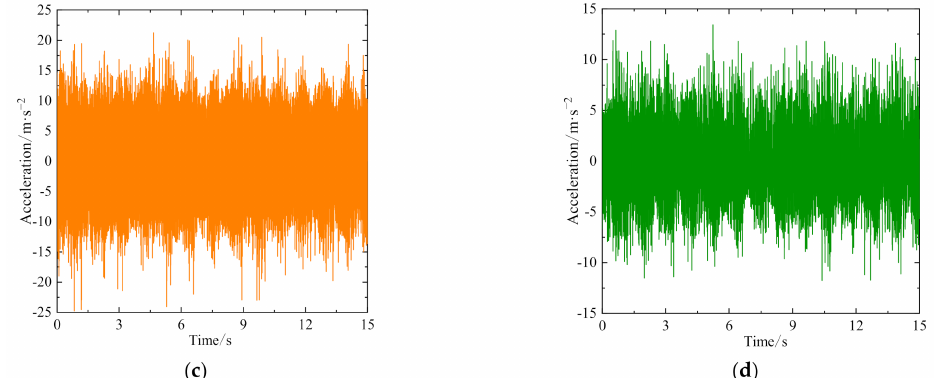
Figure 9. Time-domain characteristics of the acceleration measured in the horizontal cutting exper- iment. ( a ) x -direction of the cutting head, ( b ) y -direction of the cutting head, ( c ) z -direction of the cutting head, ( d ) y -direction of the cutting arm.